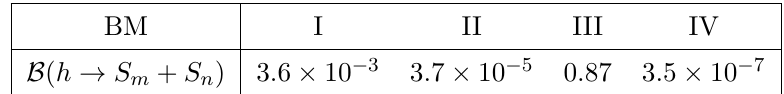
Table 3 . Branching fractions for the invisible Higgs decay into two KK scalars summed over all kinematically allowed states with (cid:14) S = (cid:14) T = 1, (cid:11) = 1 GeV and (cid:21) hS = 1.